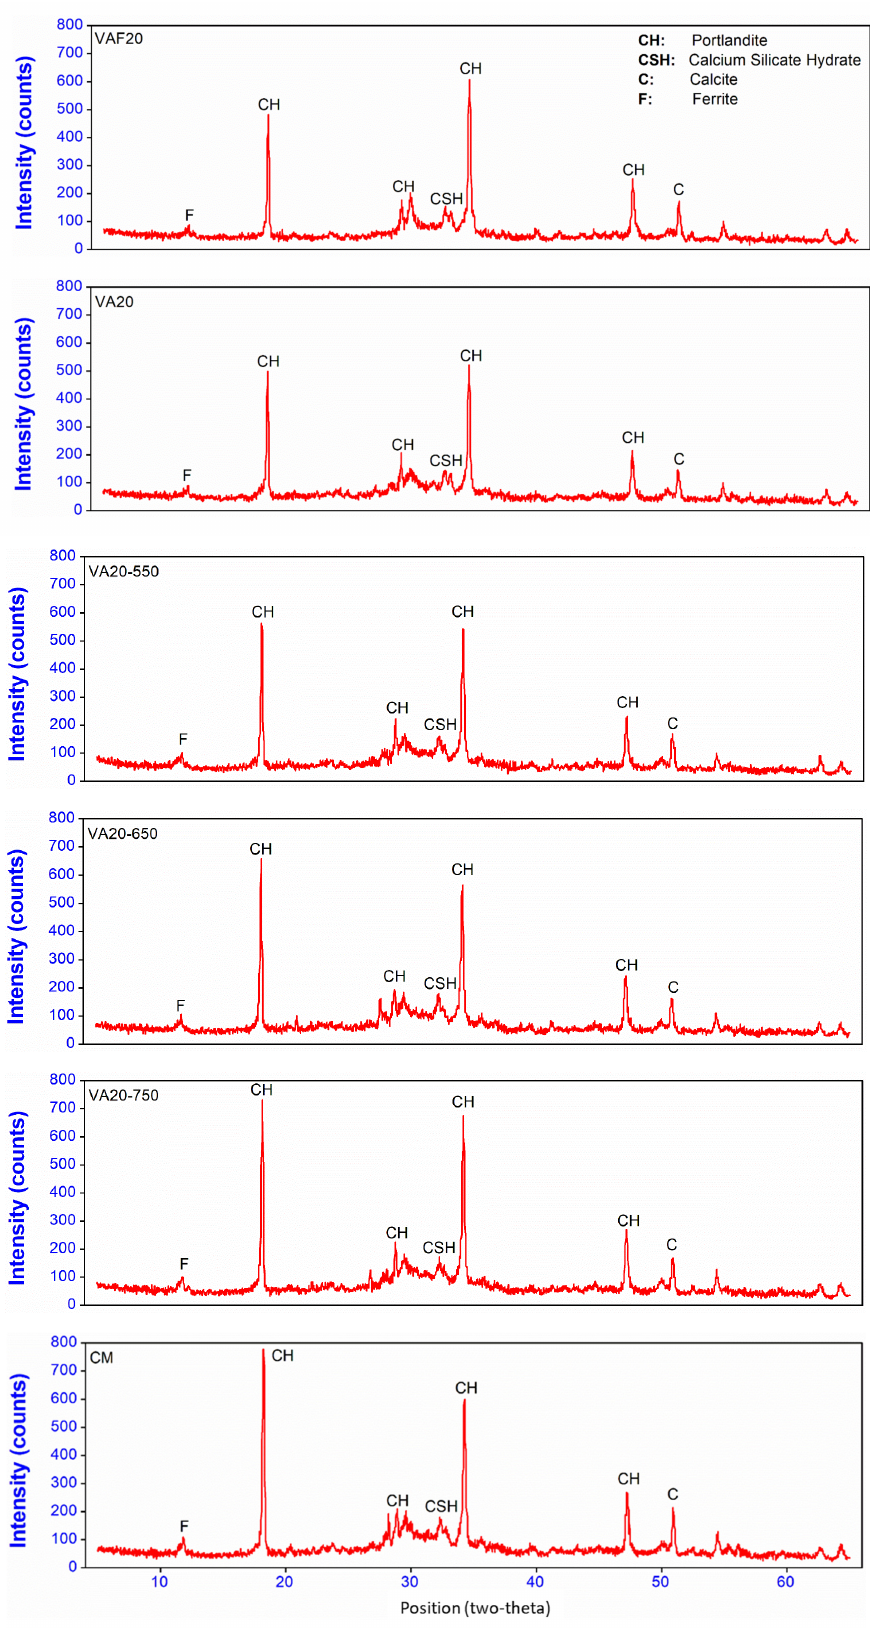
Figure 9. Comparison of XRD peaks between the control mortar (CM) paste and pastes containing different volcanic ashes at 91 days.